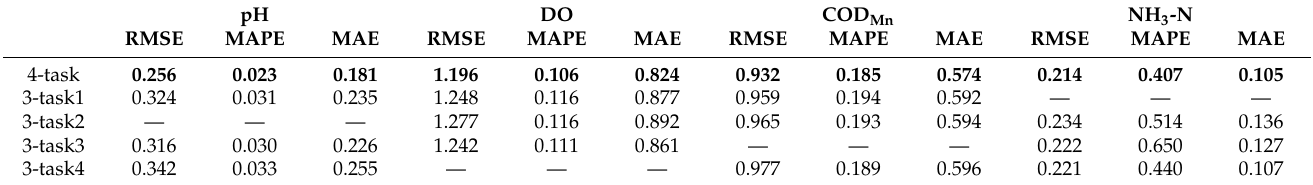
Table 5. Comparison of four indicators and three indicators multi-task learning models on